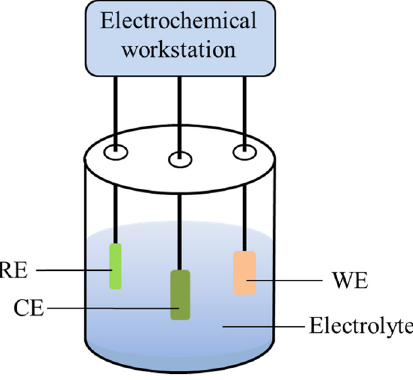
Figure 1: Schematic of the electrochemical workstation. Figure 2: FTIR spectra of ( a ) PEDOT:PSS and ( b ) PEDOT:PSS/EMI -